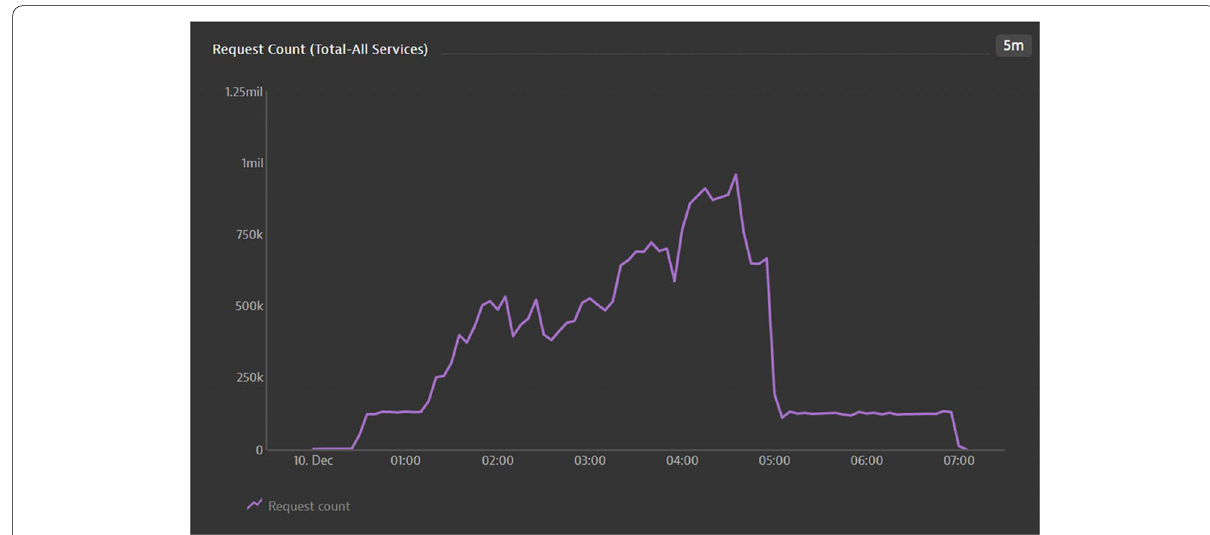
Fig. 4 Total request count of all services, both monolithic and microservice architectures, during research testing